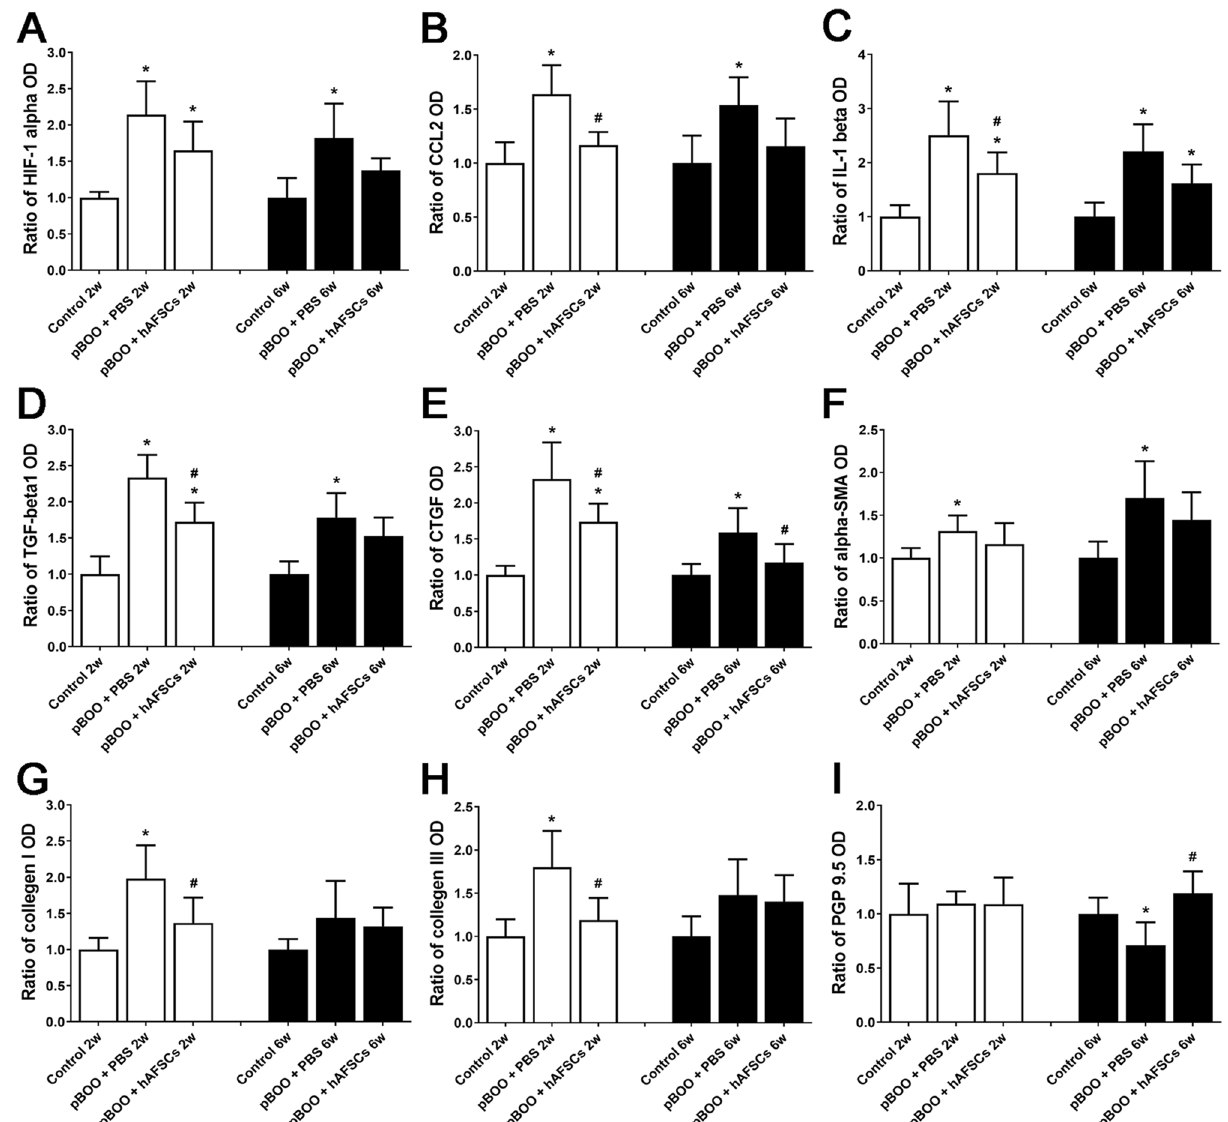
Figure 5. Expressions of the immunoreactivities of hypoxia inducible factor-1α (HIF1α, A ), CCL2 ( B ), interleukin-1β (IL-1β, C ), transforming growth factor-β1 (TGF-β1, D ), connective tissue growth factor (CTGF, E), α-smooth muscle actin (α-SMA, F), collagen I ( G ), collagen III ( H ) and protein gene product 9.5 (PGP9.5, I ) in the bladder of control, pBOO + PBS and pBOO + hAFSCs treatment. After hAFSCs treatment, the immunoreactivities of CTGF and α-SMA are improved at 2 and 6 weeks after pBOO, but HIF1α, CCL2, IL-1β, TGF-β1, collagen I and collagen III are improved only at 2 weeks after pBOO. The immunoreactivities of PGP9.5 are improved after hAFSCs treatment only at 6 weeks after pBOO. *: P < 0.05 vs. control, #: P < 0.05 vs. pBOO + PBS. N = 6 in each time